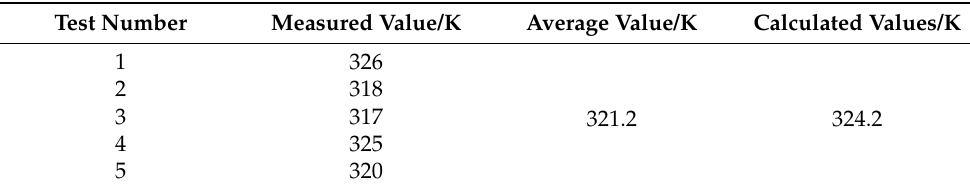
Figure 20. The temperature test device. Table 8. Comparison between simulated and measured temperature values.